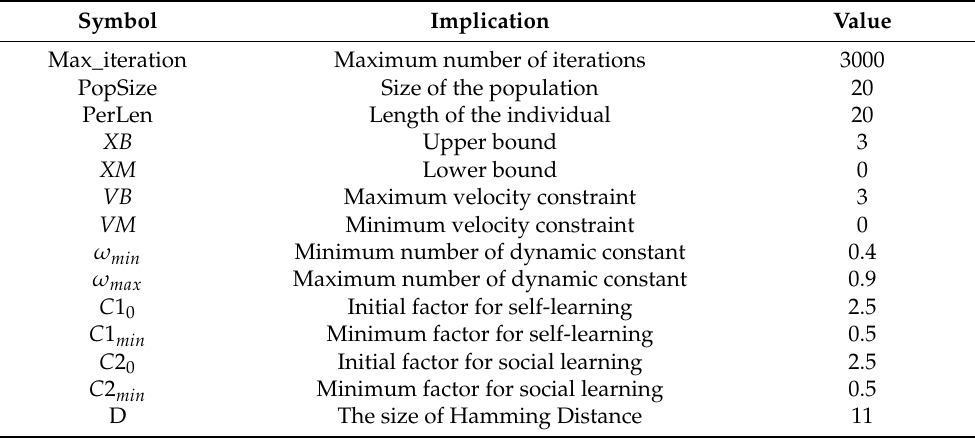
Table 2. Related parameters in IMPSO